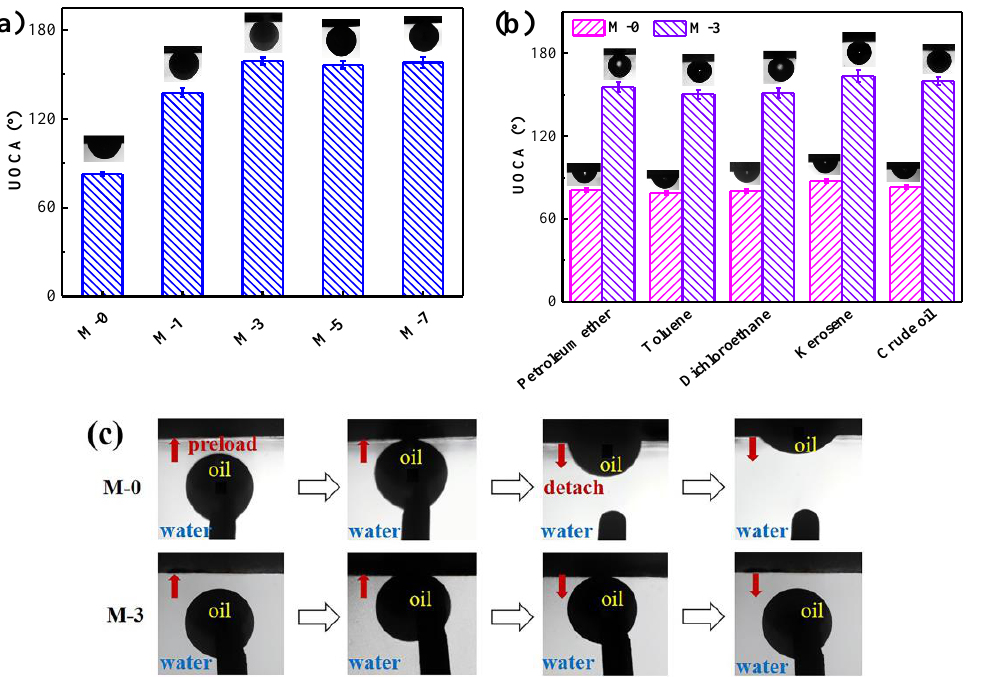
Figure 6. ( a ) Underwater oil contact angles on the surface of different membranes with crude oil. ( b ) Underwater oil contact angles on the surface of M-0 and M-3 membranes with different oils. ( c ) Dynamic underwater oil-adhesion behavior of M-0 and M-3 with crude oil.